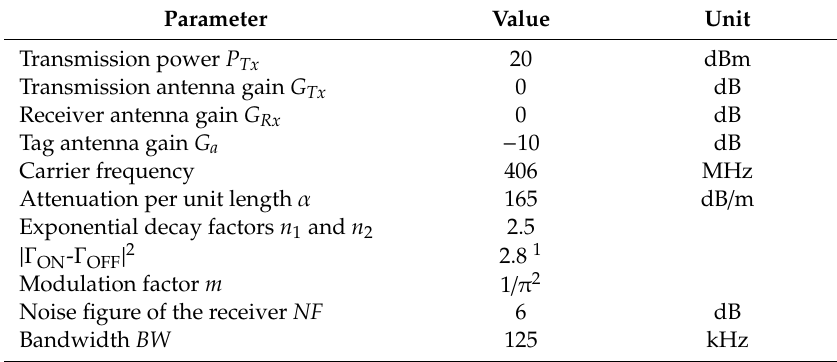
Table 2. Parameters used in link budget.